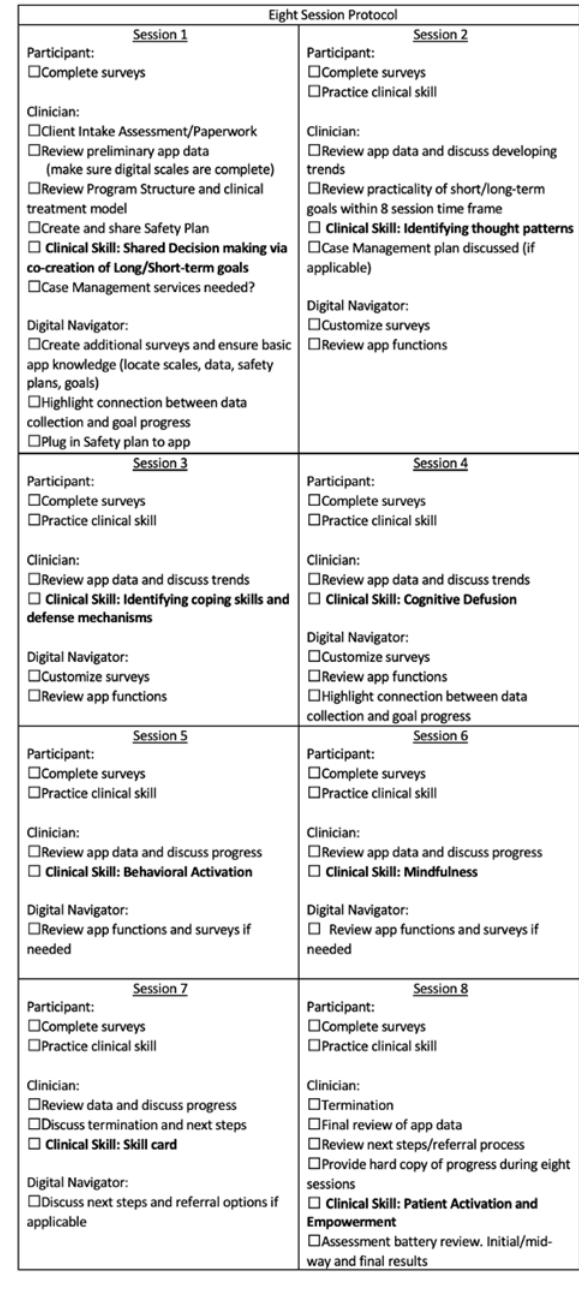
Figure 4. Overview of clinical sessions (left) and session-specific checklist